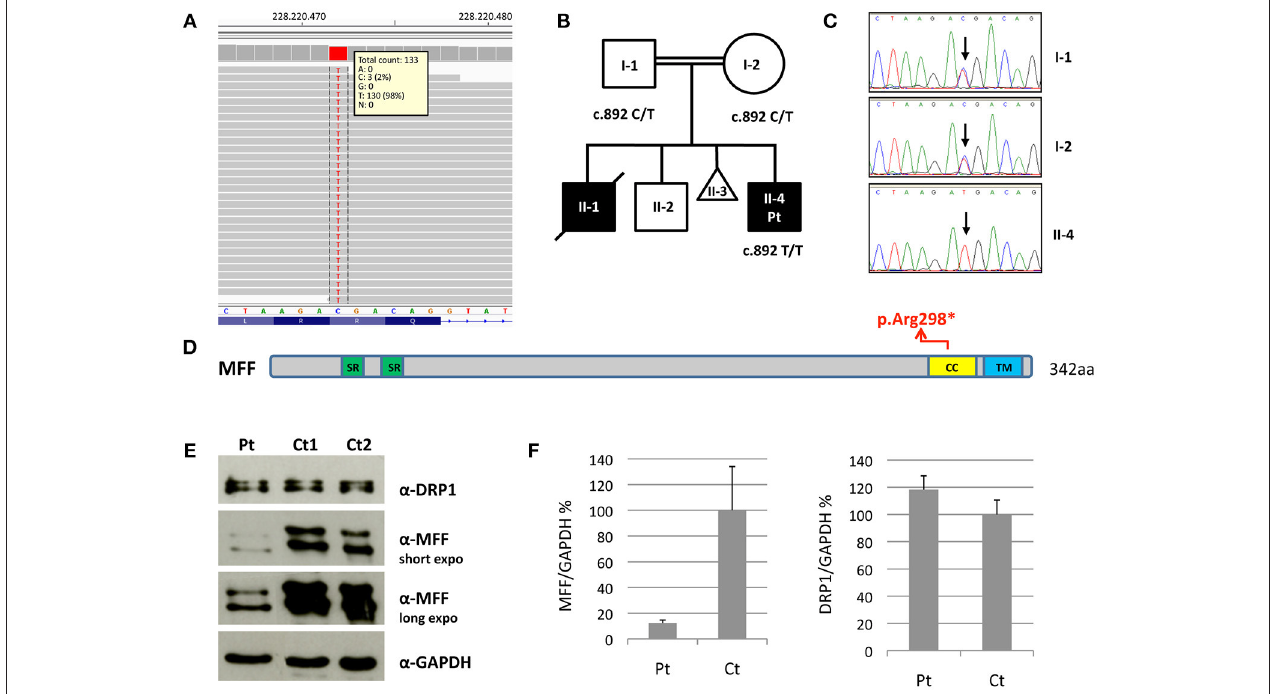
FIGURE 2 | Molecular and protein studies in a patient with MFF mutation. (A) Snapshot from IGV software of the mutation identified in the proband. (B,C) Pedigree of the family and electropherograms of the MFF region containing the c.892C > T variant. The black symbols indicate the clinically affected subjects. (D) Schematic representation of the MFF protein. Functional domains are in color: Short repeat (SR) in green; coiled-coil (CC) in yellow; transmembrane (TM) in blue. (E) Immunoblot analysis of total lysates from control subjects (Ct1 and Ct2) and patient’s (Pt) fibroblasts using α -MFF, α -DRP1 and α -GAPDH antibodies. The latter was used as loading control. Two different exposure times are reported for MFF. (F) Densitometric analysis of the immunoblots. The levels of MFF and DRP1 proteins were normalized against GAPDH and expressed as percentage relative to the average of all controls. Data are presented as mean ± SD of three experiments.